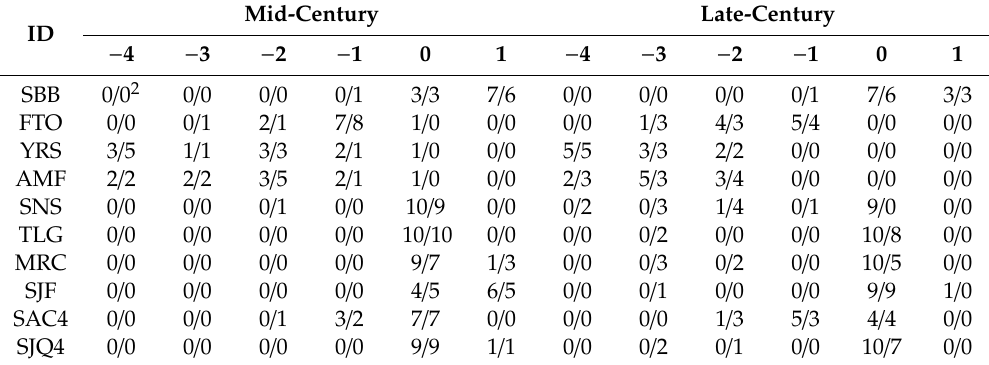
Table 2. Number of RCP4.5 and RCP8.5 projections out of 10 GCM projections showing changes in peak runo ff timing from the baseline 1 . Mid-Century ID